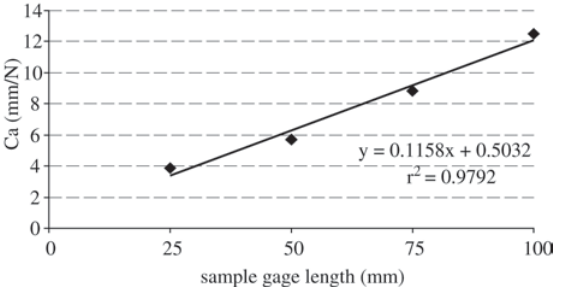
Figure 7. Graphical plot for the system (testing equipment) com- pliance for glass fibres.